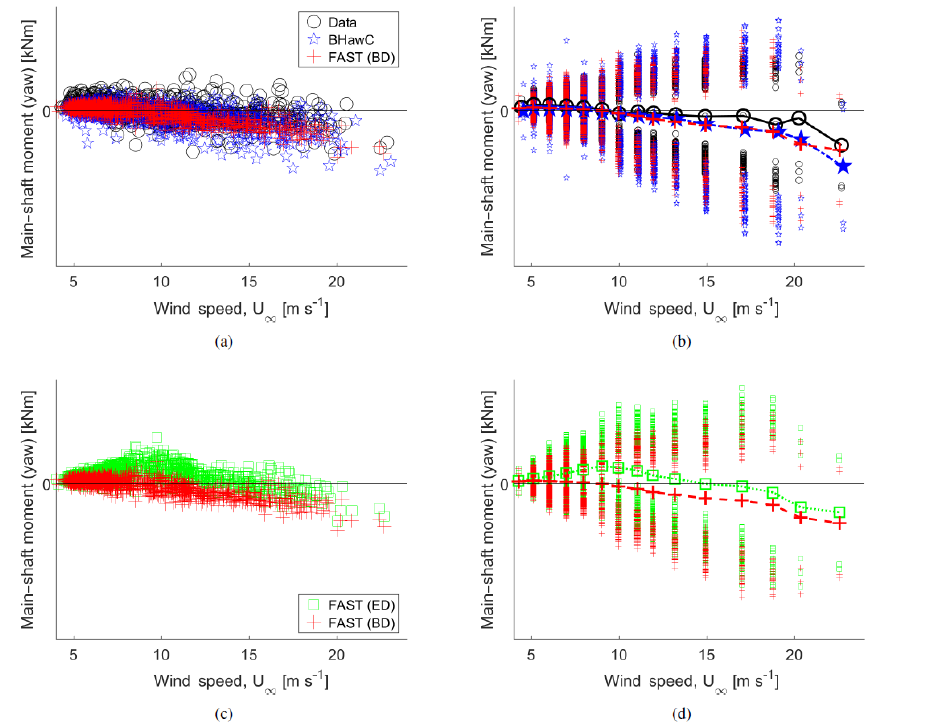
Figure 8. Main-shaft bending moment – yaw (nonrotating coordinate system). (a) Individual 10min averages from experimental data, BHawC, and FAST (BD). (b) Binned averages of data in (a) are denoted by points connected by lines; the scatter above and below these data denotes plus or minus 1 standard deviation, respectively, of the individual 10min data sets in that bin. (c) Individual 10min averages from FAST (BD) and FAST (ED). (d) Binned averages of data in (c) are denoted by the points connected by lines; the scatter above and below these data denotes plus or minus 1 standard deviation, respectively, of the individual 10min data sets in that